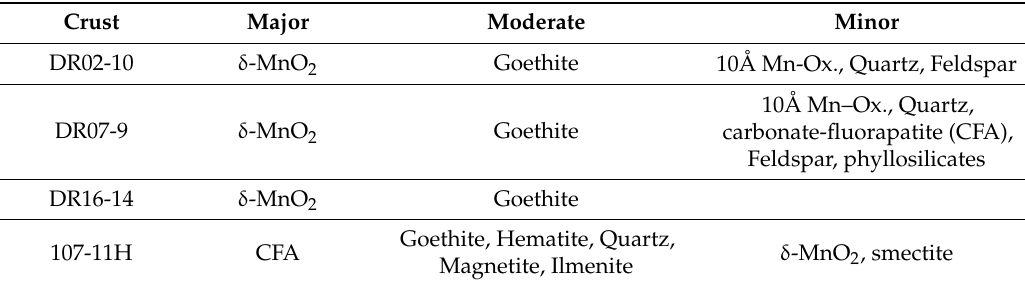
Figure 4. ( A – D ) X-Ray Diffraction (XRD) analysis of bulk samples. In samples DR02-10, DR07-9 and DR16-14 is possible recognize Fe-oxyhydroxides represented by goethite group (Gth) minerals and Mn-oxides essentially Fe-vernadite (Ver) and birnessite (Bir). ( A , B ) In samples DR02-10 and DR07-9, it is also possible to recognize ~10Å reflection due to the presence of todorokite (Tod), asbolane (Asb) or buserite (Bus). Calcite (Cal) have been detected in DR02-10, and quartz (Qtz) shows its peaks in both samples. ( D ) Sample 107-11H, on the other hand, shows the abundance of Carbonate-fluorapatite (CFA), goethite (Gth), hematite (Hem), Qtz, feldspars (Fsp), montmorillonite (Mnt) and magnetite (Mag) / ilmenite (Ilm). Table 2. X-Ray Diffraction ( XRD) mineralogy of crystalline and low crystalline phases from CISP selected crusts. Major > 25%; Moderate < 25%, > 10%; Minor < 10% based in XRD and geochemistry of studied crusts.